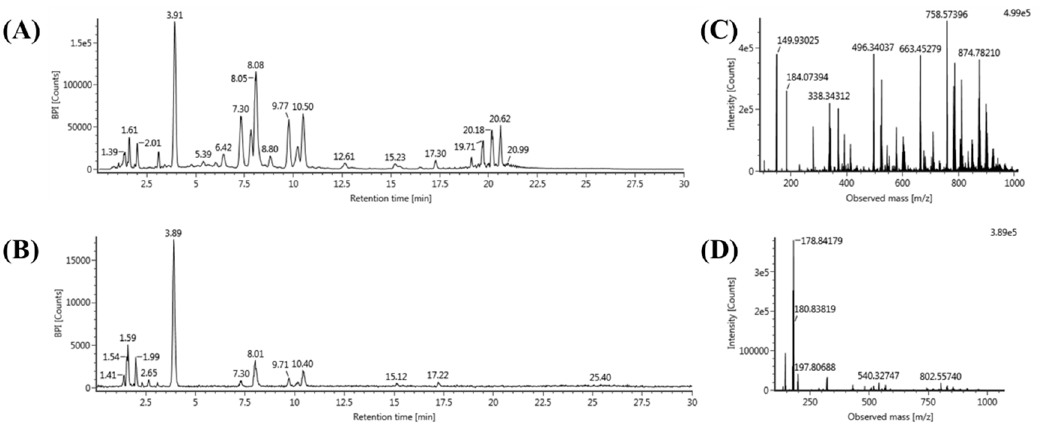
Figure 2. The base peak intensity (BPI) chromatogram of lipid extracts obtained from rat serum in the positive ion mode ( A ) and negative ion mode ( B ). Mass spectrum of lipid extracts obtained from rat serum in the positive ion mode ( C ) and negative ion mode ( D ).